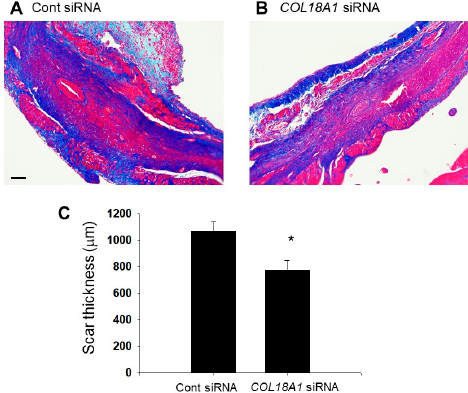
Figure 7. Azan staining for scar formation in infarcted area of siRNA-injected myocardial infarction model rats. After ligation of the LAD in rats, sixteen µg of COL18A1 siRNA or Cont siRNA was injected into the infarcted myocardium. Two weeks after the operation, the heart was isolated and then thin paraffin sections (4 µm) were made. ( A , B ) Representative Azan stained pictures of the infarcted area are shown ( A : Cont siRNA; B : COL18A1 siRNA). Blue: collagen fibers; Red: muscle fibers. Scale bar: 100 µm. ( C ) Scar thickness was measured and are shown as mean ± S.E.M. (Cont siRNA: n = 4, COL18A1 siRNA: n = 5). * p < 0.05 vs. Cont siRNA.